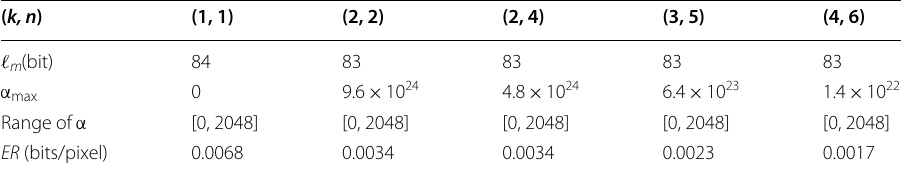
Table 5 Embedding rate of different